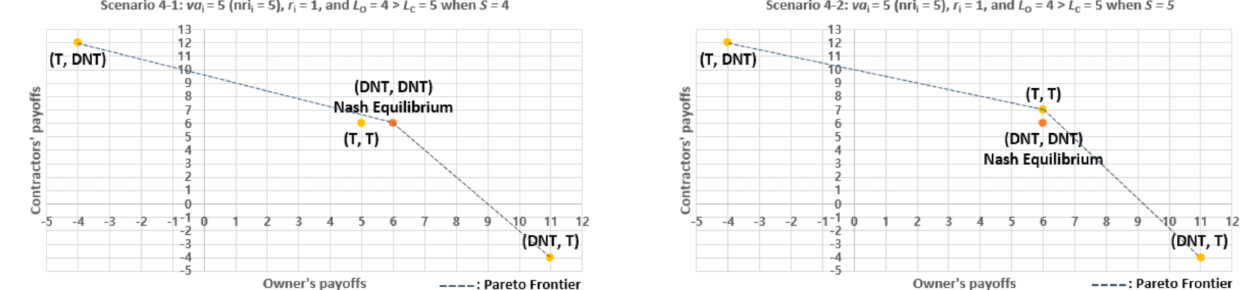
Figure 4. Nash equilibrium and Pareto frontier in Scenario